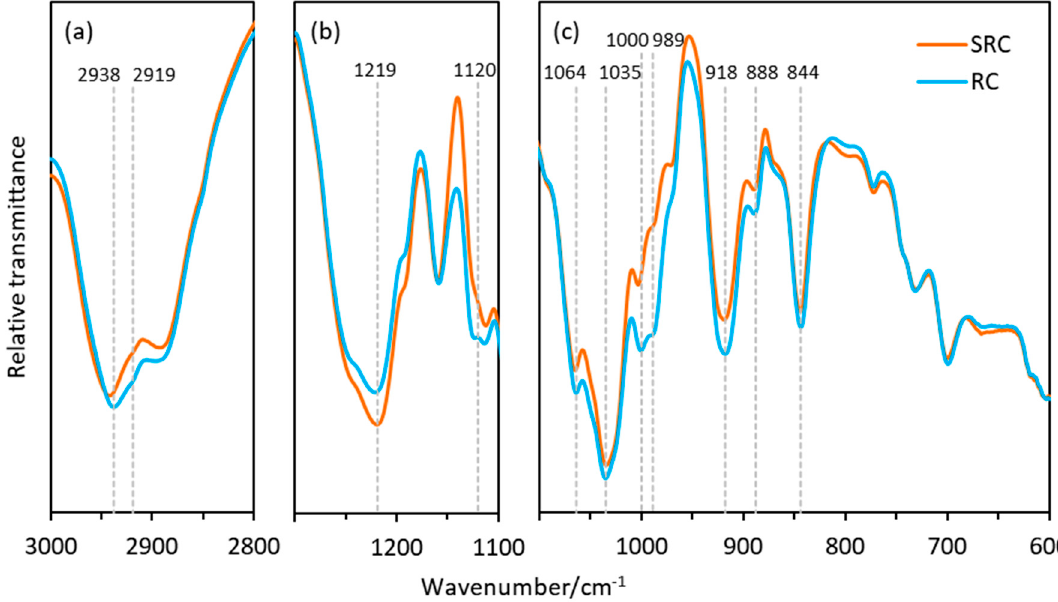
Figure 9. FTIR spectra of the SRC and RC films in the regions ( a ) 3000–2800 cm -1 , ( b ) 1300–1100 cm -1 , and ( c ) 1100–600 cm -1 . Spectra were recorded using an average of 64 scans at 4 cm -1